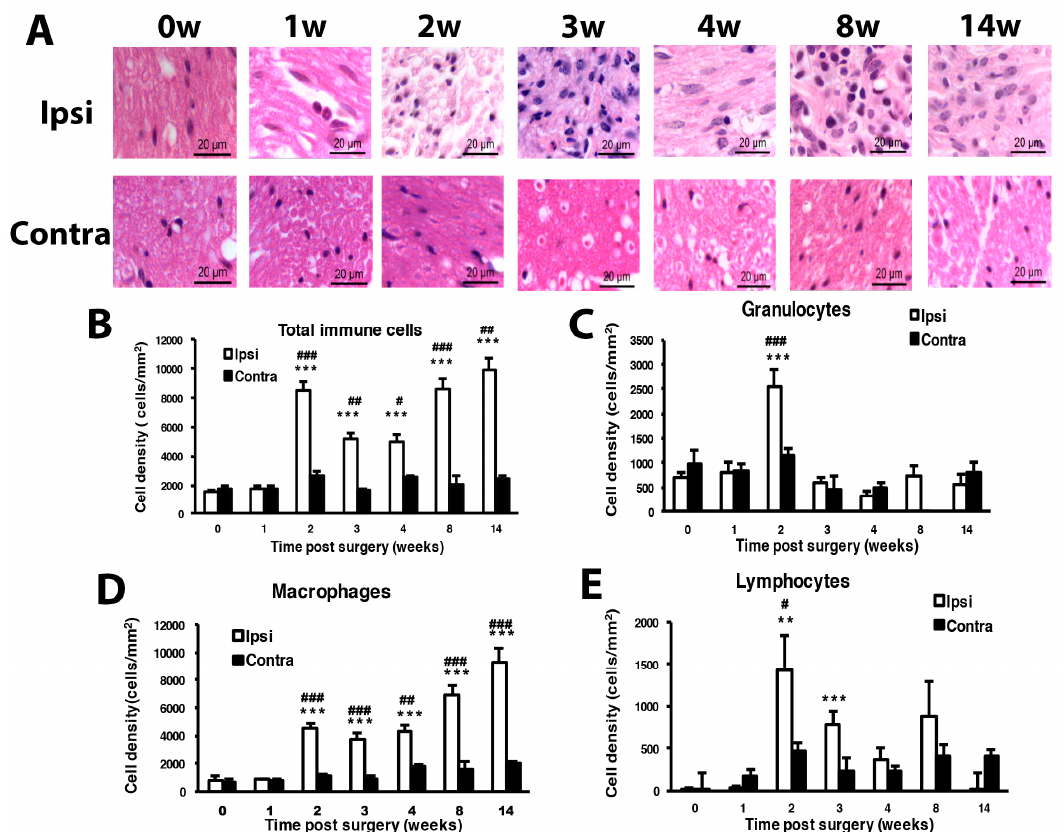
Figure 2. Mice with CCI of the sciatic nerve show long-term inflammation. Sciatic nerves were excised from the ipsilateral or contralateral side of CCI mice at 0, 1, 2, 3, 4, 8 and 14 w, fixed and cross-sectioned, followed by H and E staining. Representative H and E-stained sections showing infiltration of immune cells in the sciatic nerve ( A ). Scale bar is 20 μ m. Histograms show the cell density (cells/mm 2 ) of total immune cells ( B ), granulocytes ( C ), macrophages ( D ), and lymphocytes ( E ). The cell number was calculated from regions of 1 mm 2 to obtain cell density (0, 14 w, n = 5; 1 w, n = 4; 2, 3, 4, 8 w, n = 6 mice). # p < 0.05; ## p < 0.01; ### p < 0.001 for ipsilateral vs. contralateral side, and ** p < 0.01, *** p < 0.001 for different weeks vs. 0 w by two-way ANOVA with post-hoc Bonferroni test.